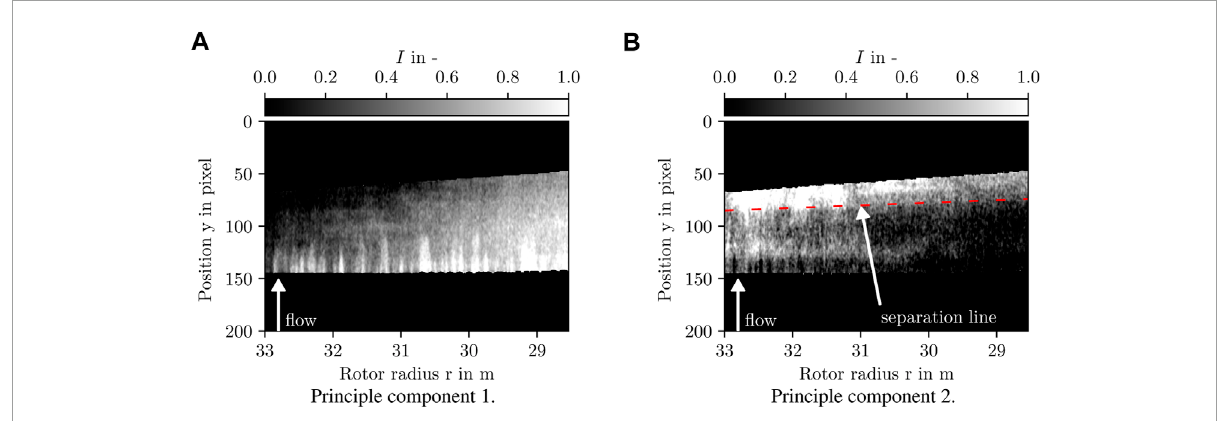
FIGURE 9 Evaluation of 20 consecutive thermographic images acquired during the occurrence of unsteady flow separation over a duration of 67 s by means of a PCA. The PCA enables an extraction of time-varying flow information. The marked separation line in the second principle component (dashed line) is detected over the entire radial width of the field of view with the maximum image resolution of 8 mm on the basis of the image